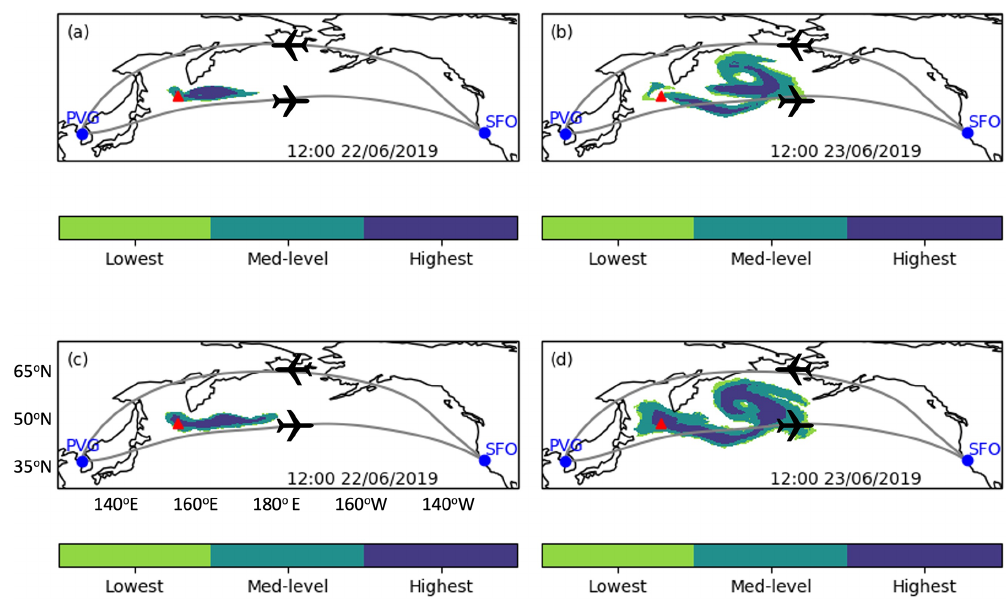
Figure 9. Overall ash concentration risk map at (a, c) 12:00UTC on 25 June 2019, (b, d) 12:00UTC on 23 June 2019 for (a, b) simulations with posterior emissions with matching ensemble meteorology and (c, d) simulations with prior emissions with ensemble meteorology. Green shading indicates the lowest level of risk, turquoise shading indicates medium-level risk and purple indicates the highest level of risk. The grey line indicates a hypothetical flight route between San Francisco (SFO) and Shanghai (PVG) international airports, with the black aeroplane icons indicating the direction of travel between